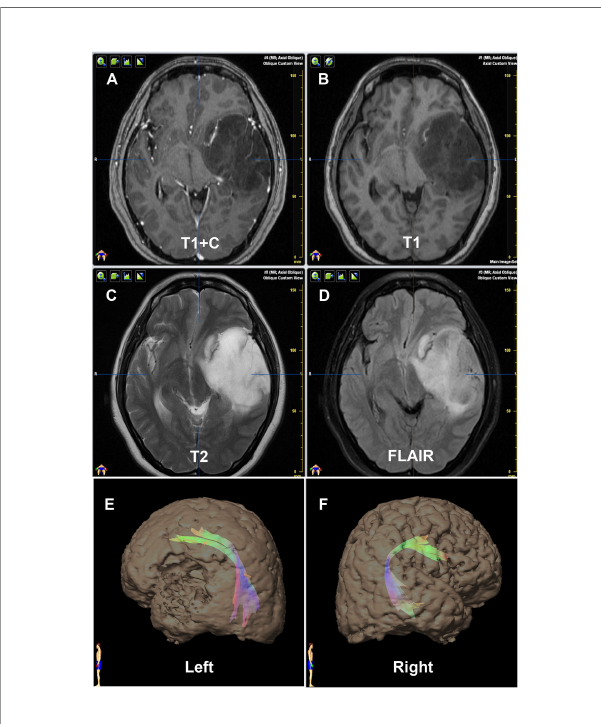
FIGURE 3 | Contrast of bilateral AF by DTT of Patient No. 21. Panels (A – D) are preoperative MRI T1+C, T1, T2, and FLAIR, respectively, on one same transverse slice of Patient No. 21, who was diagnosed as primary LGG involving Broca ’ s area. Panels (E, F) show that the relative more fi ber number and volume of AF are on the left hemisphere, which are in concordance with the language dominant side of Wada test.